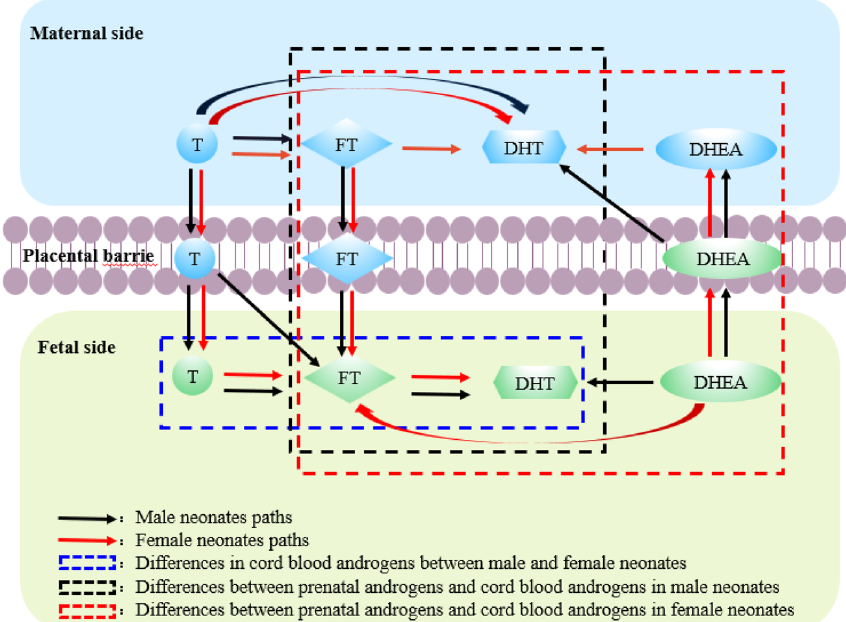
Figure 6. The graphic abstract of association between prenatal androgens and cord blood androgens. Notes: T testosterone, FT free testosterone, DHT dihydrotestosterone, DHEA dehydroepiandrosterone; Black arrow, male neonates paths; Red arrow, female neonates paths; Blue dotted frame, differences in cord blood androgens between male and female neonates; Black dotted frame, differences between prenatal androgens and cord blood androgens in male neonates; Red dotted frame, differences between prenatal androgens and cord blood androgens in female